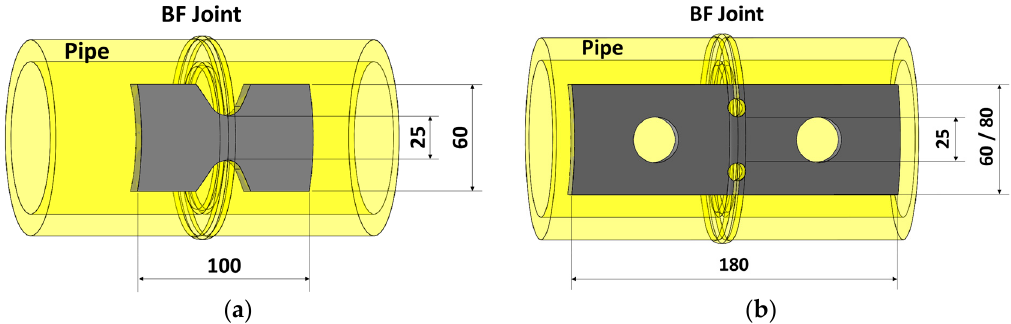
Figure 1. Diagram of relative positions of Type A specimens (unit: mm): ( a ) TWT; ( b ) WT.